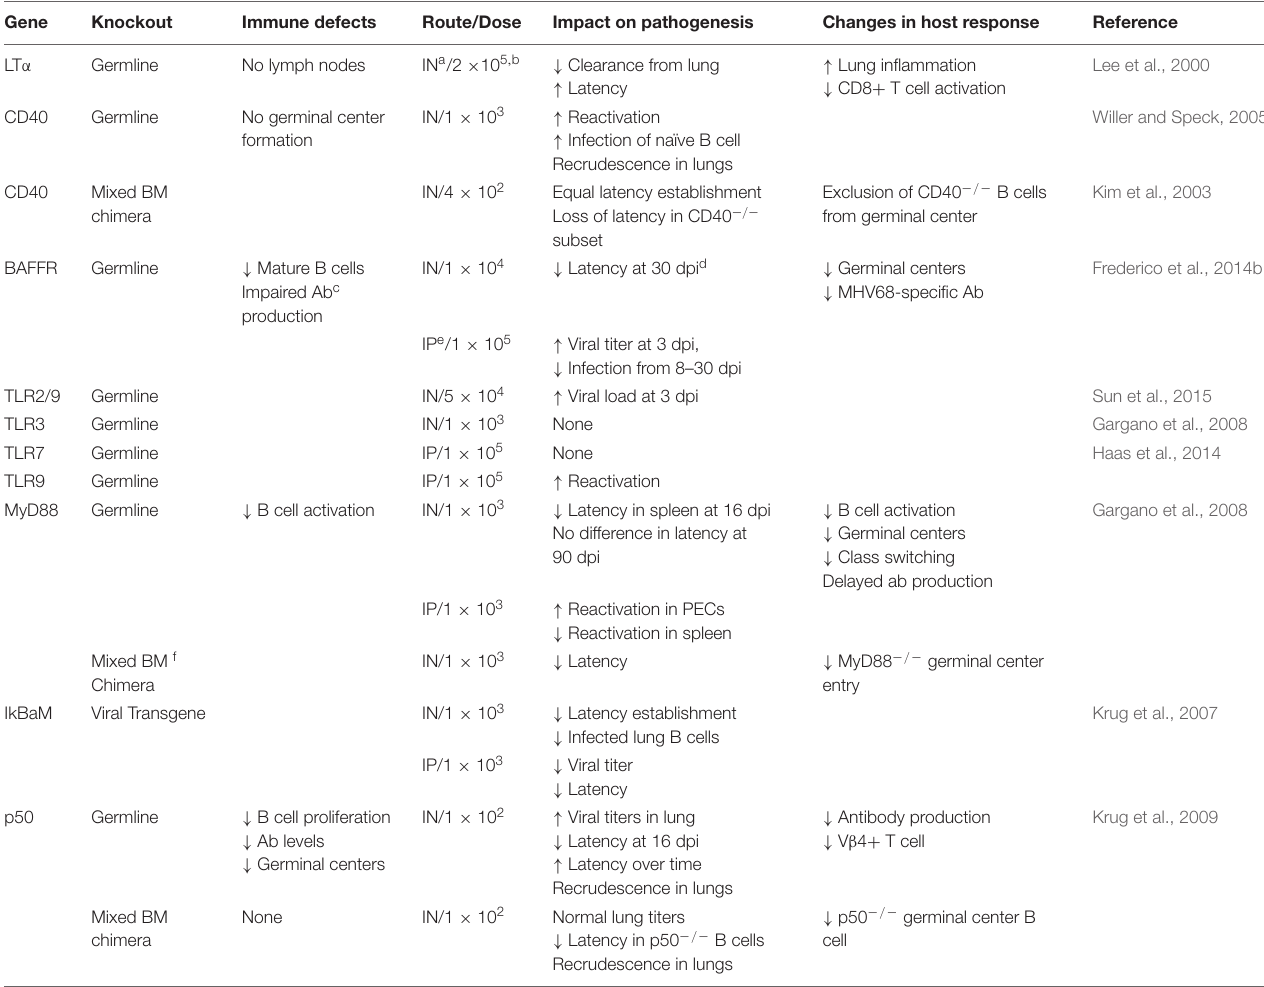
TABLE 2 | In vivo studies of the role of NF- κ B signaling on MHV68 pathogenesis.